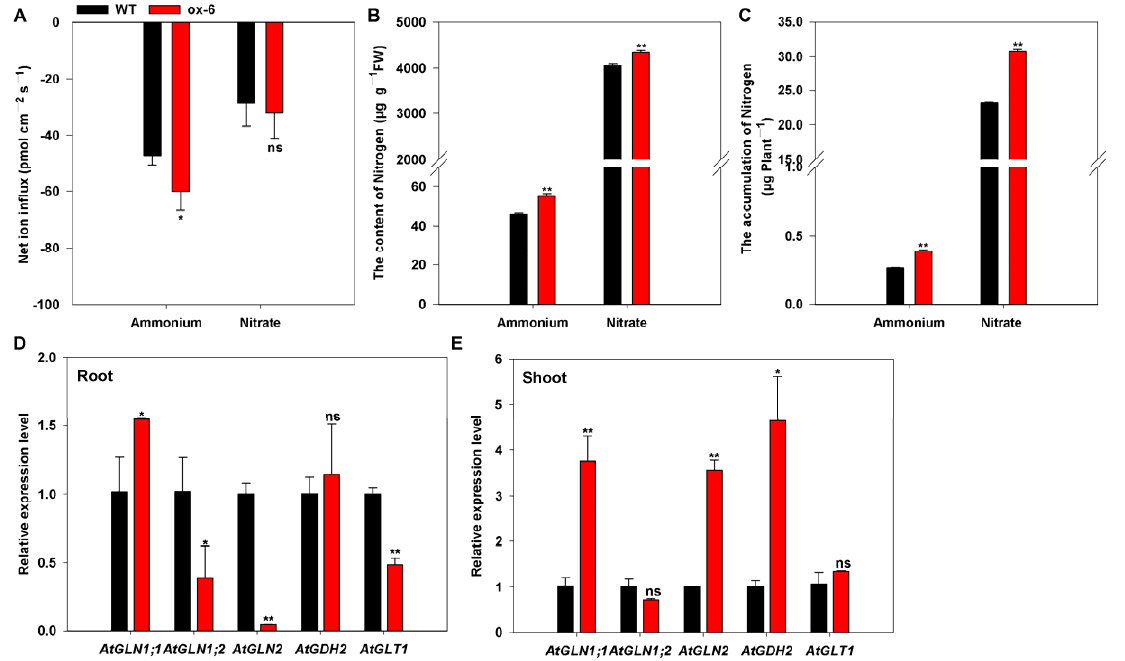
Figure 11. Overexpressing BcAMT1;5 in Arabidopsis improves plant growth at the mixture nutrition of 0.0625 mmol L − 1 NH 4+ + 0.1875 mmol L − 1 NO 3 − as N source. ( A ) NH 4+ and NO 3 − ion fluxes. ( B ) NH 4+ and NO 3 − content. ( C ) NH 4+ and NO 3 − accumulation. The expression levels of N assimilation genes in roots ( D ) and in shoots ( E ). WT and ox-6 present wild-type and the line 6 of overexpressing BcAMT1;5 , respectively. Data represent mean ± SE ( n = 16 in A; n = 3 in ( A – E )), ns represents no significant difference, * and ** in the histogram shows significant differences at p < 0.05 and p < 0.01, respectively.